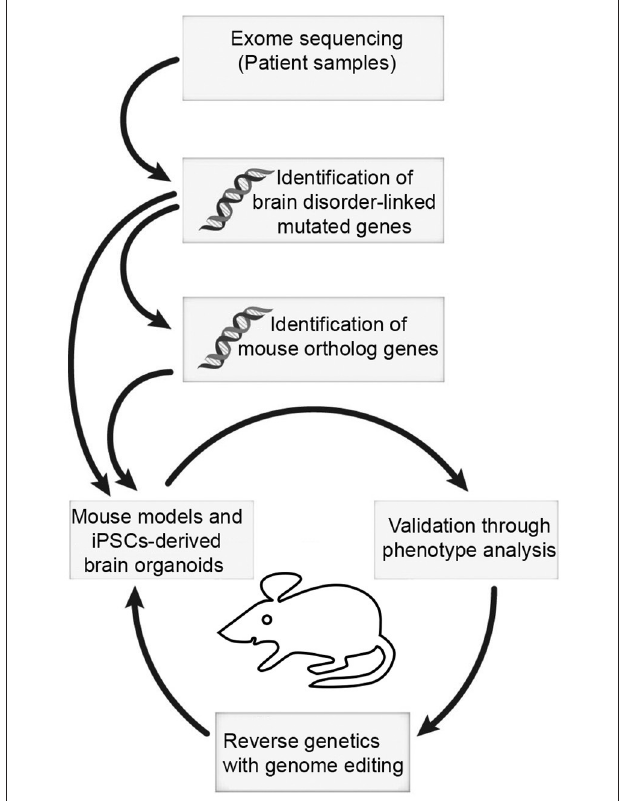
FIGURE 3 | The mouse and iPSC-derived mini-brain organoid pipeline for modeling human brain disorders. Candidates of mutations involved in brain disorders are identified using exome sequencing with DNA samples from patients. When mouse orthologs of candidate genes are identified, they can be edited. Subsequently, phenotypic studies are used to assess validity of the model. Upon validation, reverse genetics approach with genome editing will be applied to restore